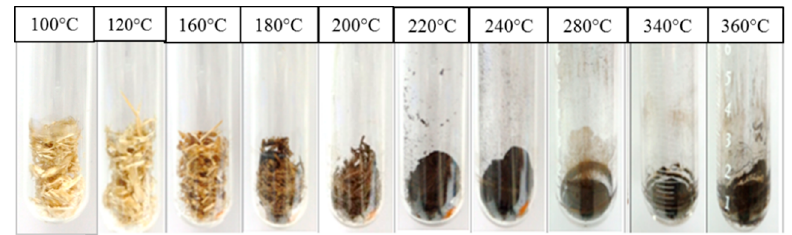
Figure 7. Photographs of the solid residue of OPT21 after a 5 min reaction time under different sub-CW temperatures.